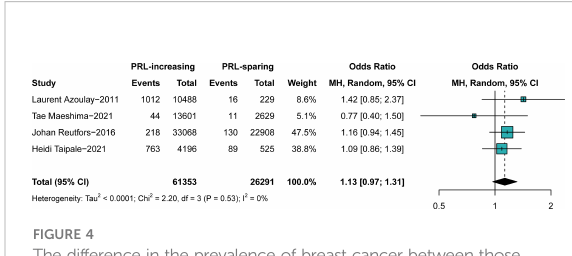
FIGURE 4 The difference in the prevalence of breast cancer between those exposed to prolactin-increasing or prolactin-sparing antipsychotics. Point sizes are an inverse function of the precision of the estimates, and bars correspond to 95% CIs. PRL,